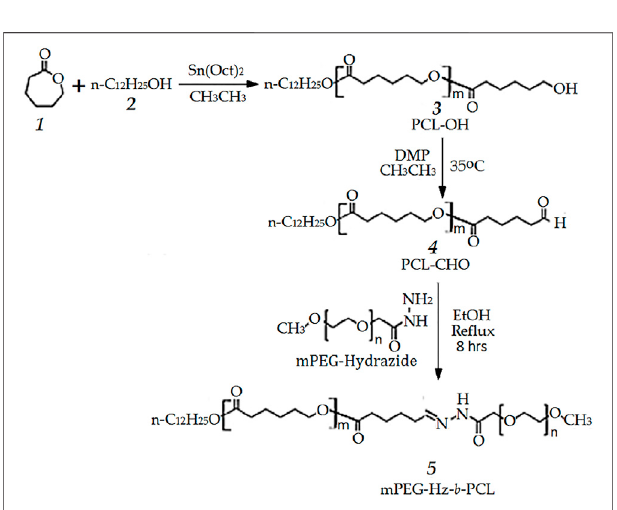
SCHEME 1 | Preparation of methoxy polyethylene glycol-hydrazone- block-polycaprolactone block copolymer.